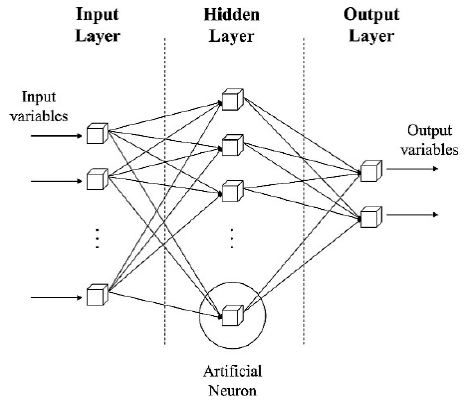
Figure 5. The structure of artificial neural networks (ANNs) [38].